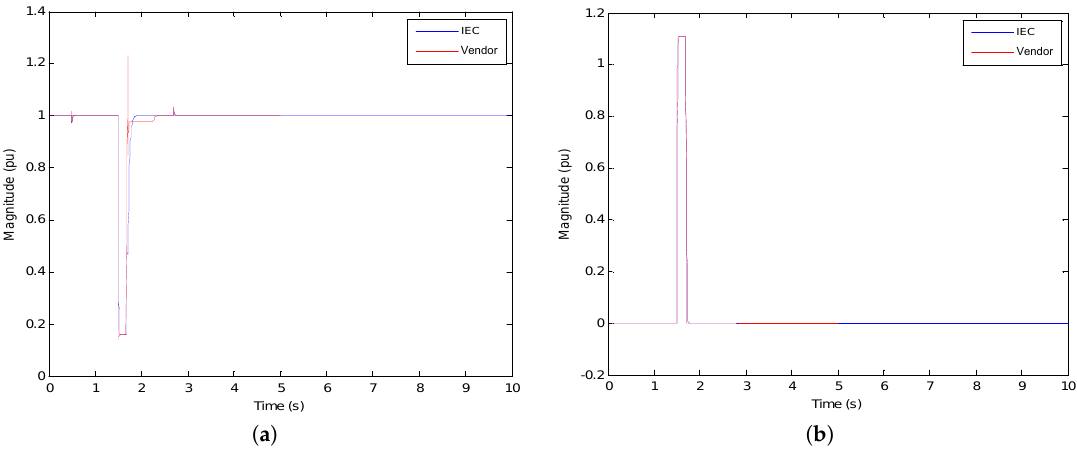
Figure 13. Type IVA results. Simulation scenario: p = 1.0 pu, u = 0.20 pu, t = 200 ms. ( a ) Active power, p ; and ( b ) reactive current, i q .